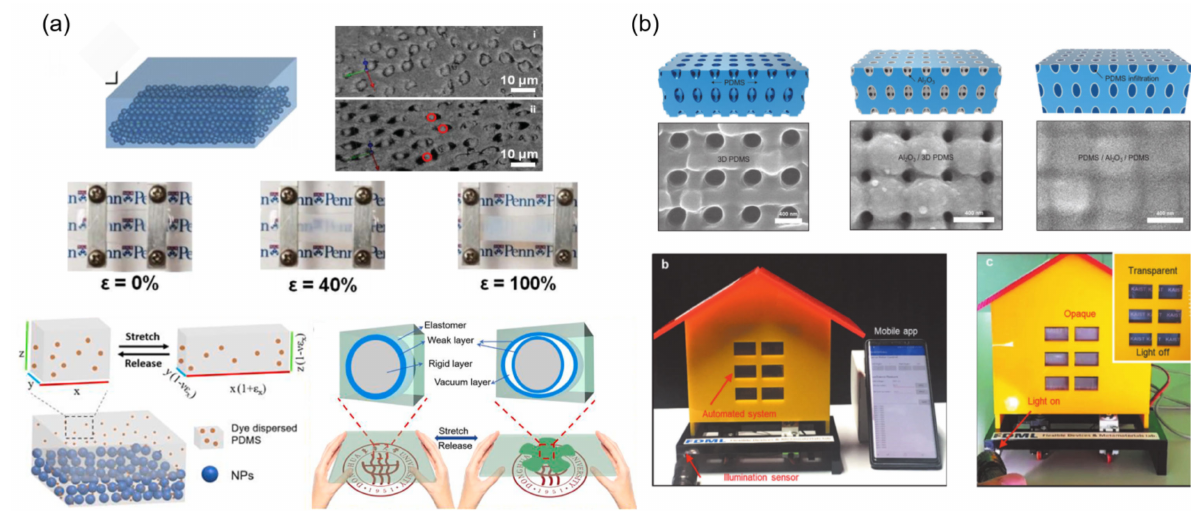
Figure 4. Methods to novel interface dynamic generation: ( a , b ) phase separation due to huge elastic modulus difference [38–40] Copyright 2015, John Wiley and Sons, 2021, Elsevier and 2020, John Wiley and